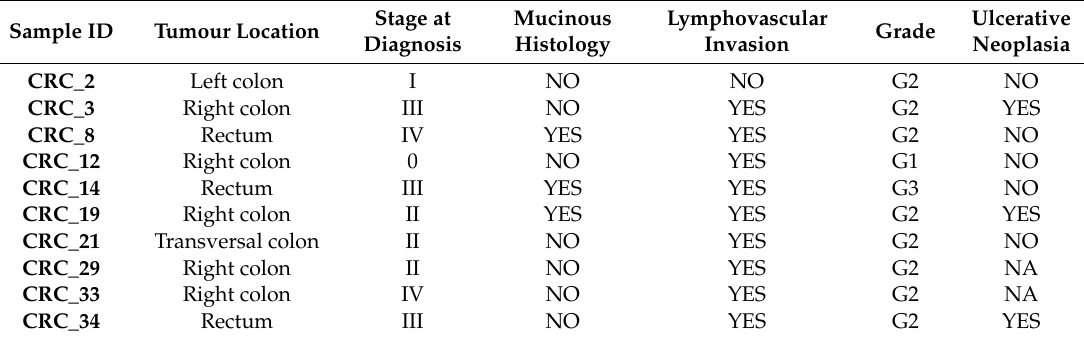
Table 3. Clinical characteristics of CRC